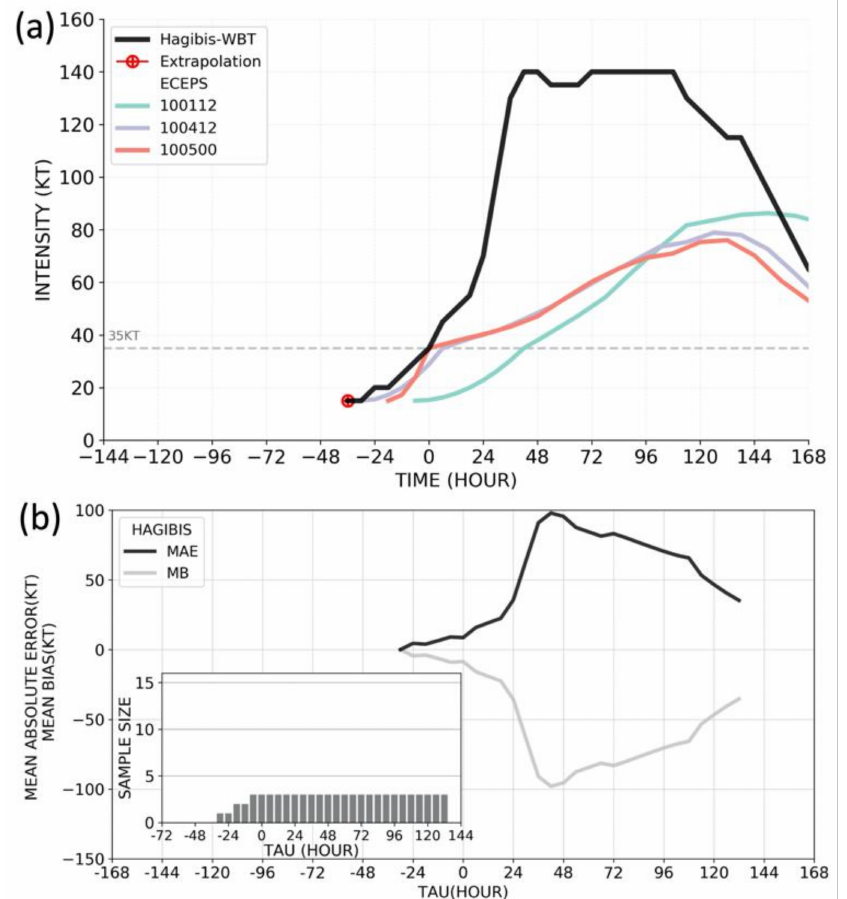
Figure 8. ( a ) Modified WAIP intensity (knots) forecast verifications for the ECEPS-predicted T2F (35 kt) as in Figure 4b, except for the pre-STY Hagibis (2019) circulations. ( b ) Intensity MAEs (solid line) and intensity MBs (gray line) as in Figure 4d,f except for pre-STY